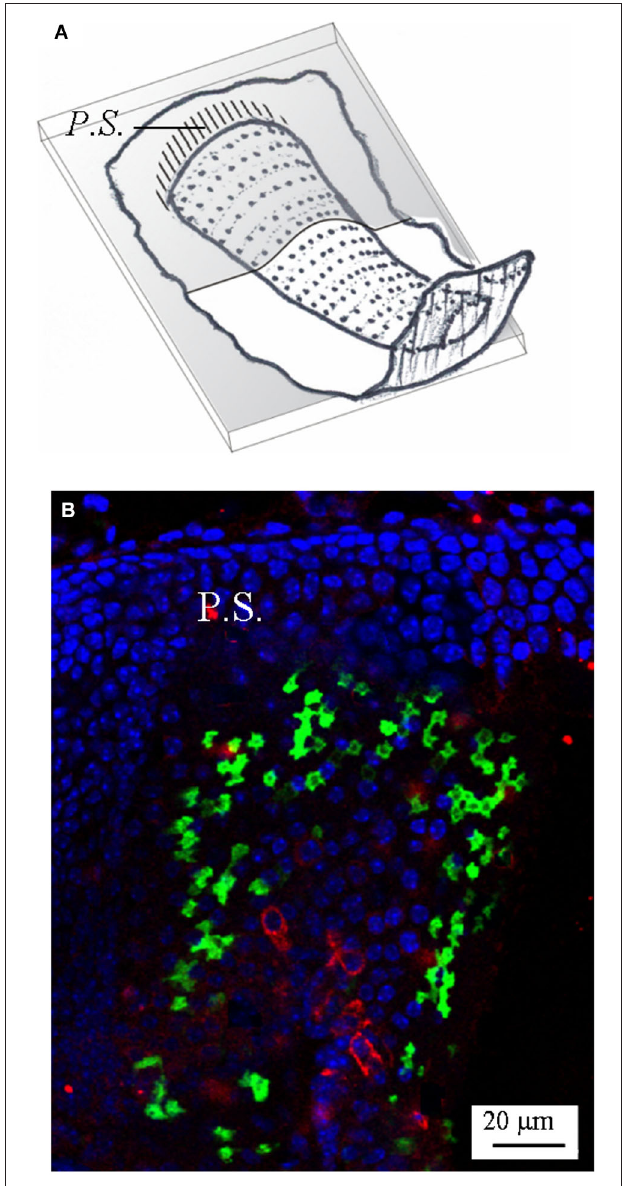
FIGURE 6 | Calbindin expression in the mouse horizontal crista . (A) Schematic representation showing the plane of the section. (B) Photomicrograph of a longitudinal confocal section showing the cell nuclei (blue; DAPI), GAD67 (green; GFP), and calbindin (red; antibody) expression—merged image. Note that most calbindin immunolabeling is concentrated in the central zone, where it marks several calyx endings.